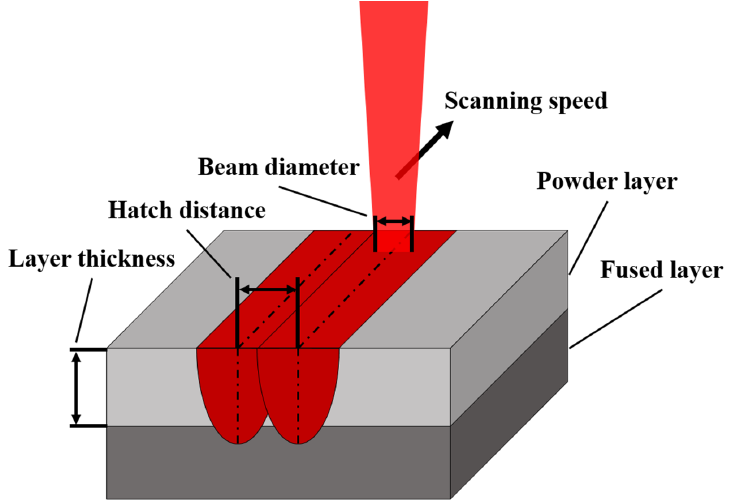
Figure 17. Operation parameters of the LPBF process.